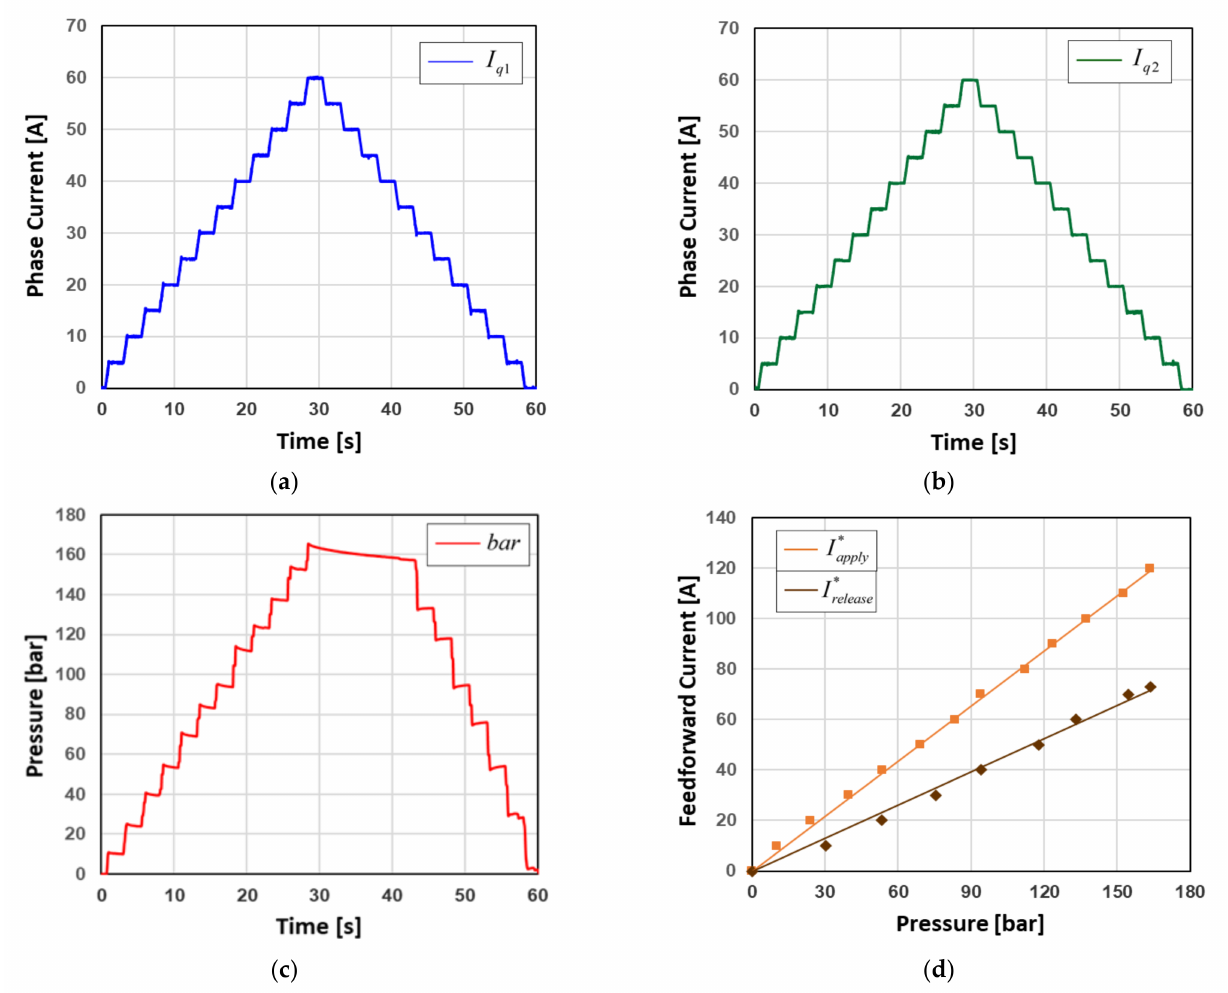
Figure 2. According to the applied current reference: ( a ) changes in the current of motor coil-1; ( b ) changes in the current of motor coil-2; ( c ) generated pressure according to the current of motor coil- 1 and coil-2; ( d ) extracted feedforward current reference of the DW-PMSM for generating